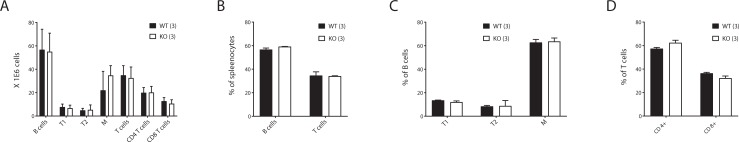
Peripheral (spleen) B and T lymphocytes development without C9orf82 protein.(A) Absolute counts of mature B and T cells with their main subpopulations are indicated (see text for specific markers used). (B-D) Frequencies of mature B and T cells and their specific B cell subsets, and T cell subsets are compared.